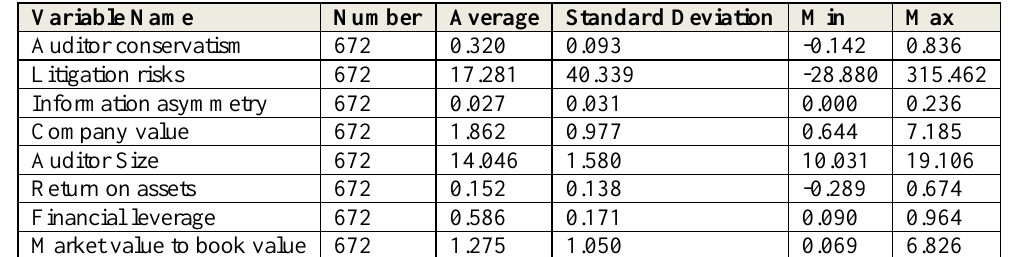
Table 1. Descriptive statistics of research variables